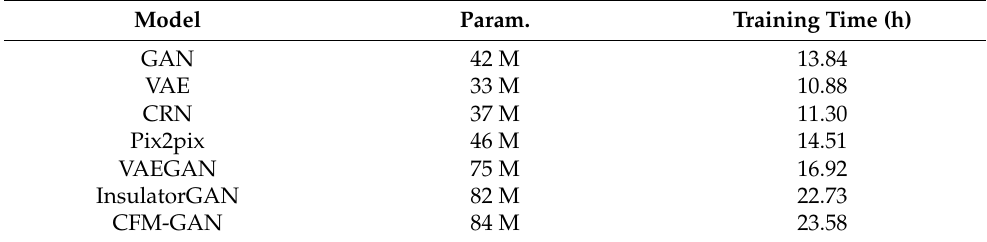
Table 12. Network parameters (Param.) and the training time of various models. Model Param. Training Time (h) GAN 42 M VAE